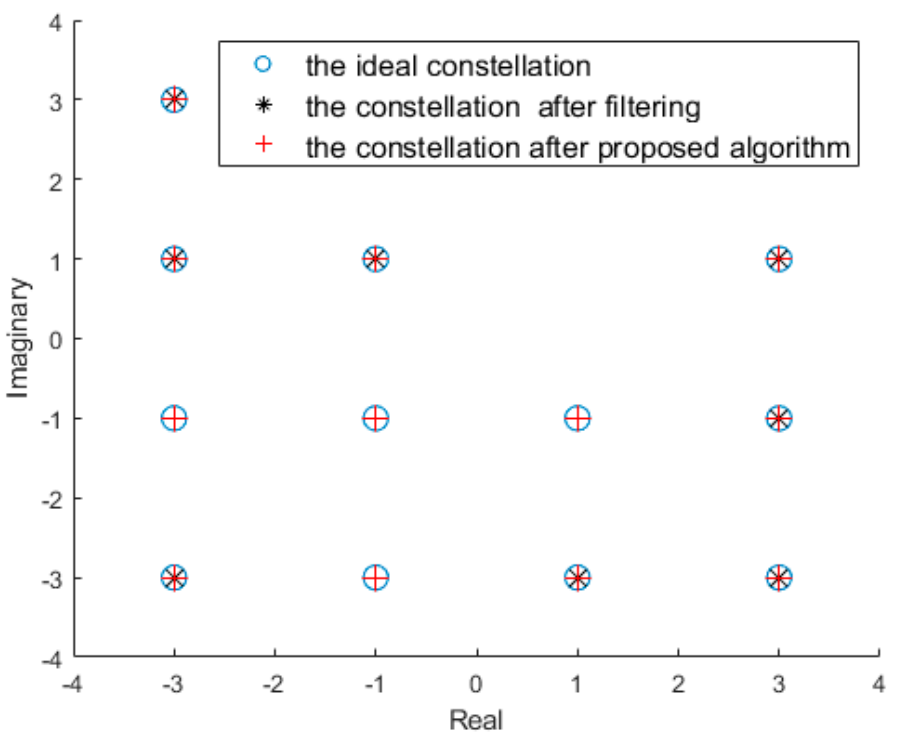
Figure 9. The results of the constellations of the ideal, proposed algorithm and filtering (strong